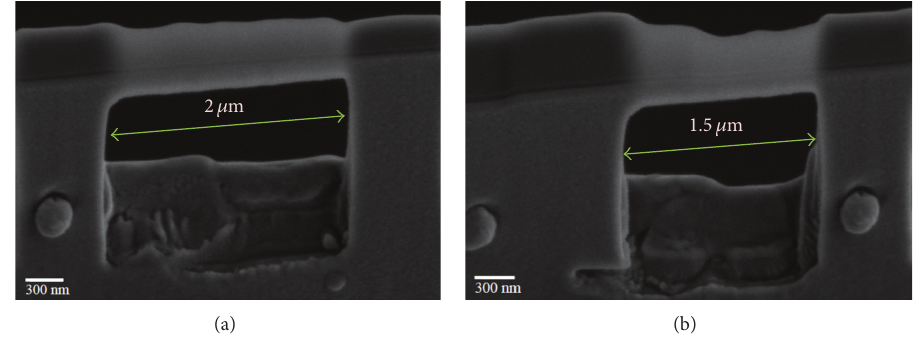
Figure2:Tilted45 ∘ top-viewFESEMimagesofnanobeamswith2.0 𝜇 m(a)and1.5 𝜇 m(b)inlengthand250 nminwidthafterbeingmachined by FIB.